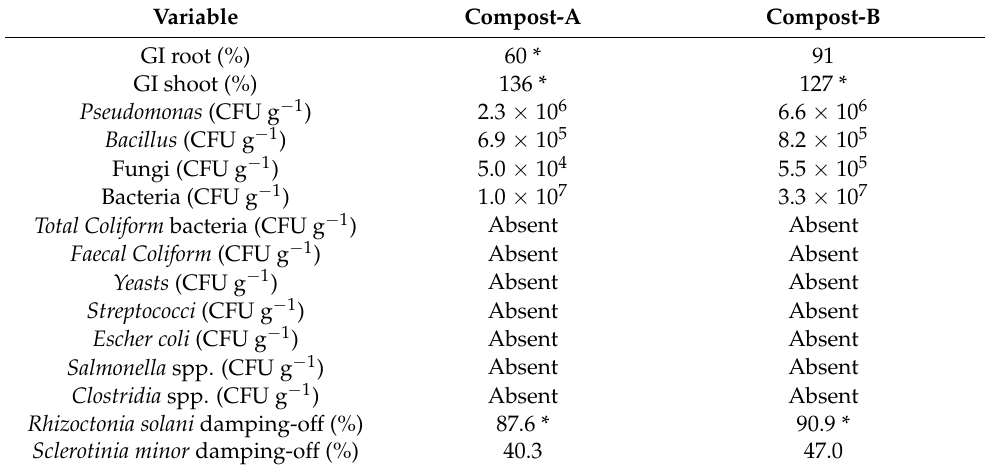
Table 3. Phytotoxicity assessment, and microbiological and suppressiveness characterization of Compost A and B. * = statistically significant difference at p -value < 0.05; CFU = colony forming unit. Variable Compost-A Compost-B GI root (%) 60 * 91 GI shoot (%) 136 * 127 * Pseudomonas (CFU g − 1 ) 2.3 × 10 6 6.6 × 10 6 Bacillus (CFU g − 1